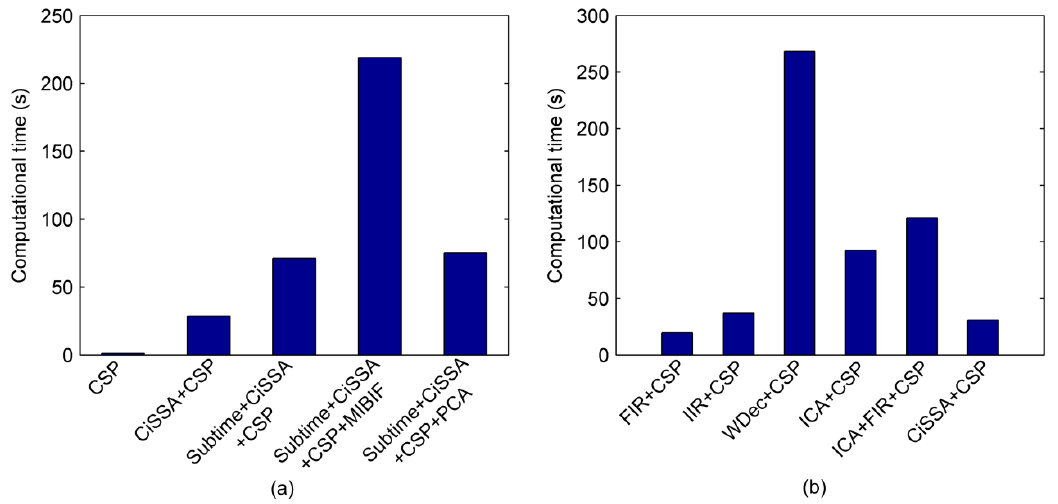
Figure 12. Computational time taken by different methods on Competition III dataset IVa with 10-fold cross-validation. ( a ) Computational time taken by CSP, CiSSA + CSP, Subtime + CiSSA + CSP, Subtime + CiSSA + CSP + MIBIF and Subtime + CiSSA + CSP + PCA. ( b ) Computational time taken by FIR + CSP, IIR + CSP, WDec + CSP, ICA + CSP, ICA + FIR + CSP and CiSSA + CSP. Table 7. Comparison of average computational time for testing one trial with different competing methods for subject aa